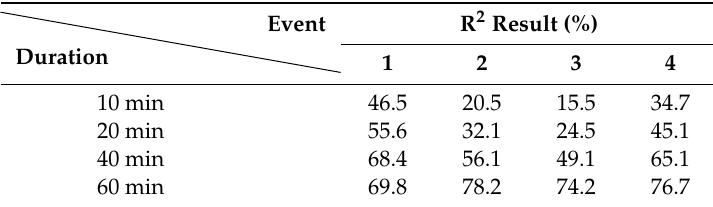
Table 9. Correlation (R 2 ) between unit rainfall and observed water